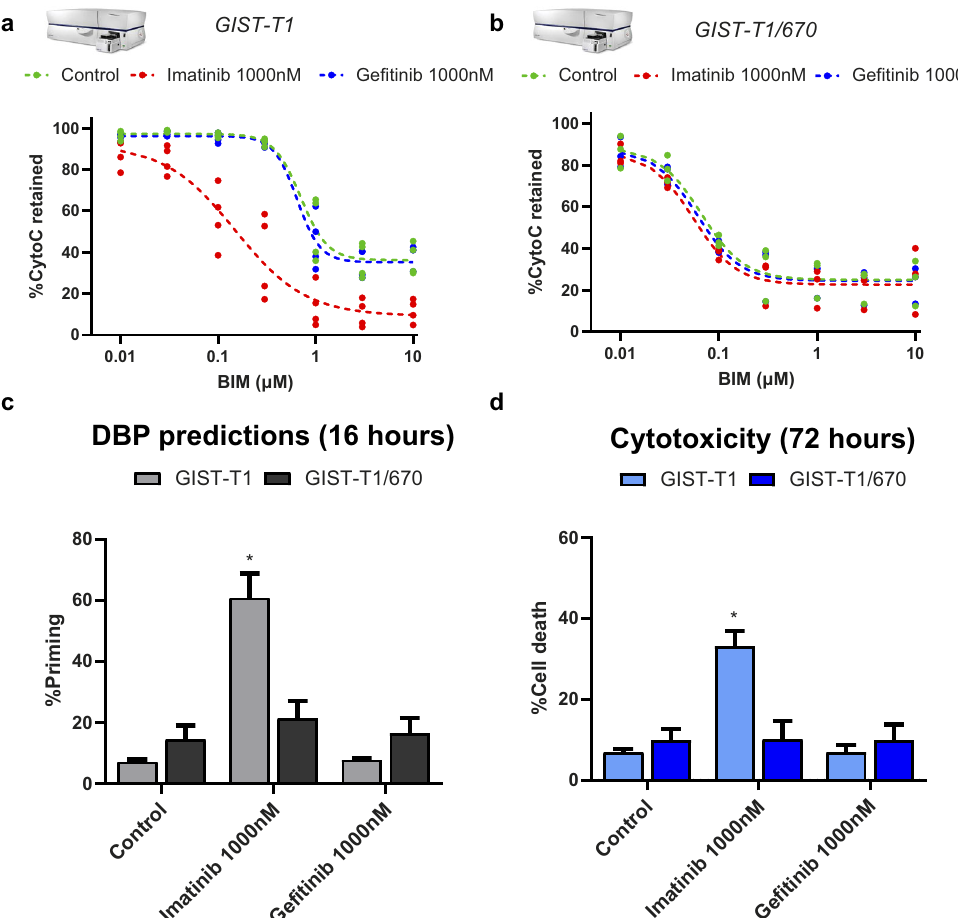
Fig. 2 FACS-based DBP identi fi es imatinib as an effective treatment in GIST-T1 cell line. a GIST-T1 and b GIST-T1/670 FACS-based DBP curves after incubation for 16 h with DMSO, imatinib, and ge fi tinib. Results are represented as the percentage of cells with cytochrome c retained inside the mitochondria after incubation with increasing concentrations of BIM peptide. c Quanti fi cation of % priming (percentage of cells with cytochrome c scape) in GIST-T1 and GIST-T1/670 cells. Values were chosen in the BIM peptide condition where the DMSO-treated cells started to engage MOMP and lose cytochrome c staining. d Cytotoxicity was measured as % cell death using Annexin V/propidium iodide (PI) staining. GIST-T1 and GIST-T1/670 cells were treated for 72 h with DMSO, imatinib, and ge fi tinib. All results are expressed as the mean ±SEM. of at least three biologically independent replicates. * indicates a p value <